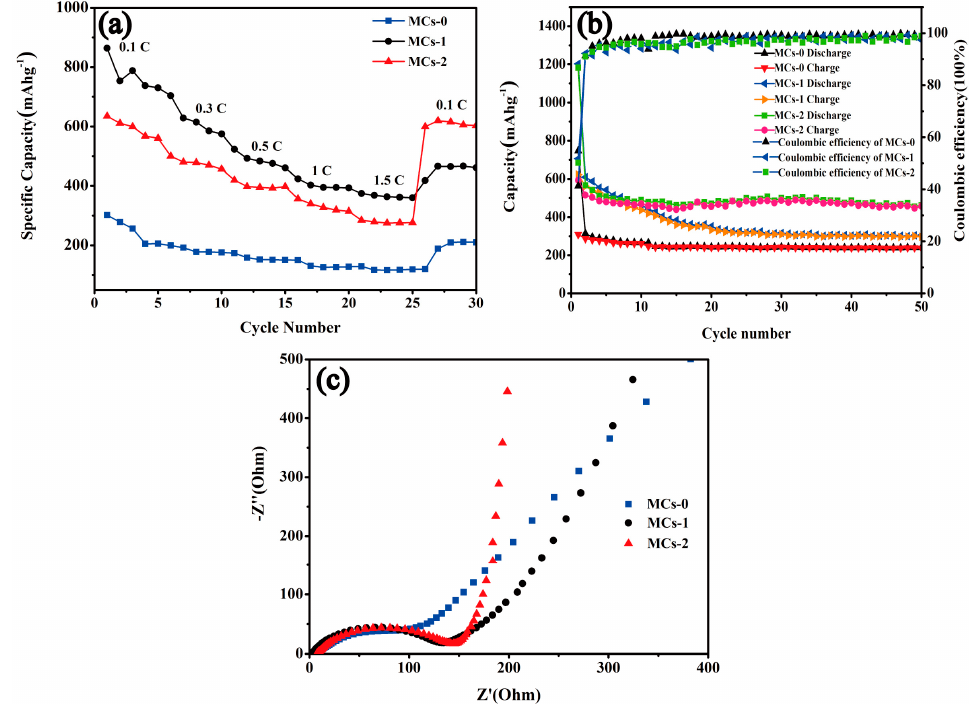
Figure 8. ( a ) Rate capacities of MCs-0, MCs-1, and MCs-2 electrodes; ( b ) Plots of capacity and Coulomb efficiency versus cycle number for the MCs-0, MCs-1 and MCs-2 electrodes ( c ) Nyquist plots of the MCs-0, MCs-1, and MCs-2 electrodes.